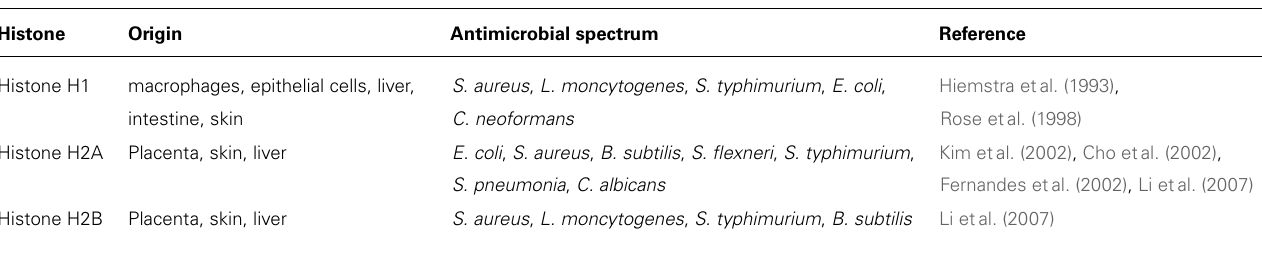
Table 4 | Short overview of histones and their antimicrobial